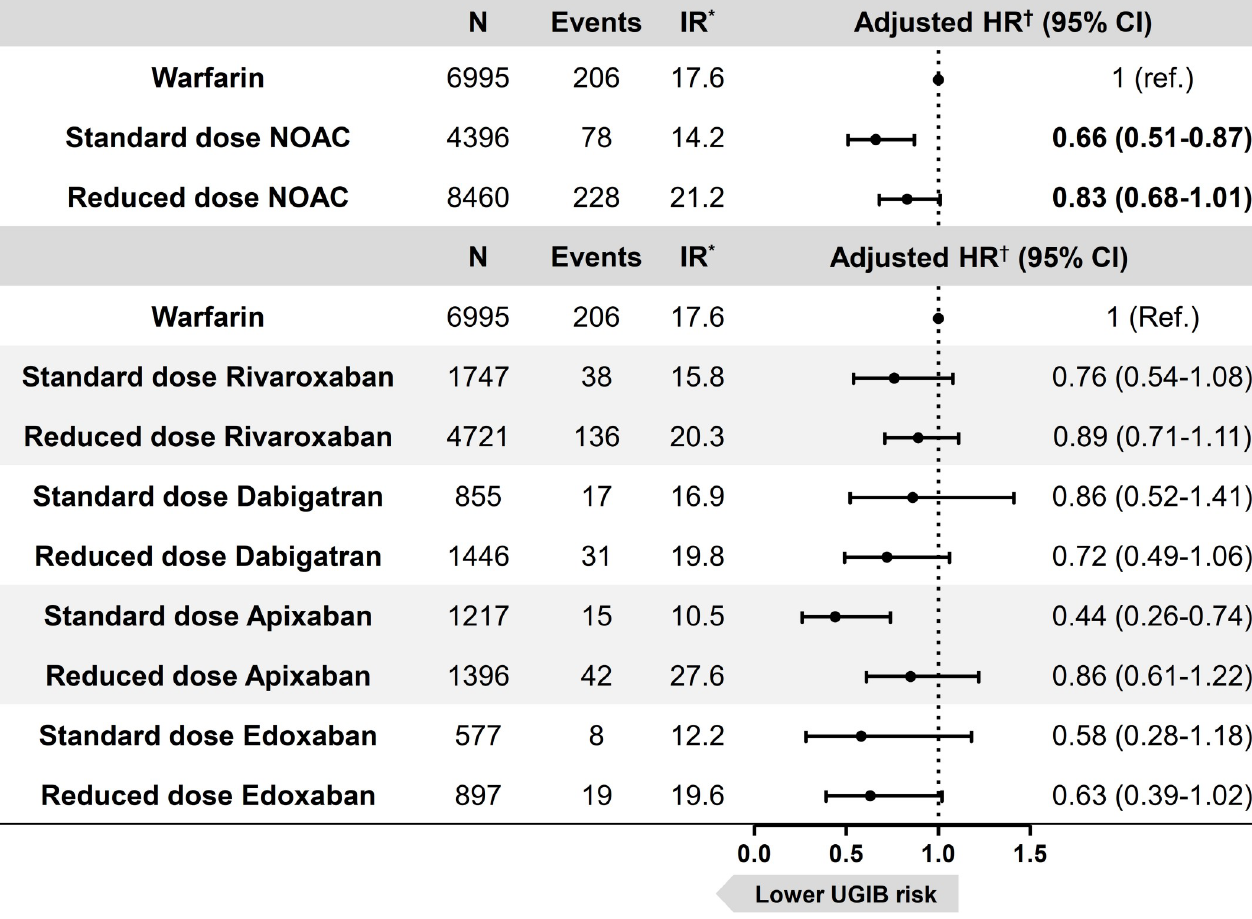
PLOS ONE | https://doi.org/10.1371/journal.pone.0253310 June 17,